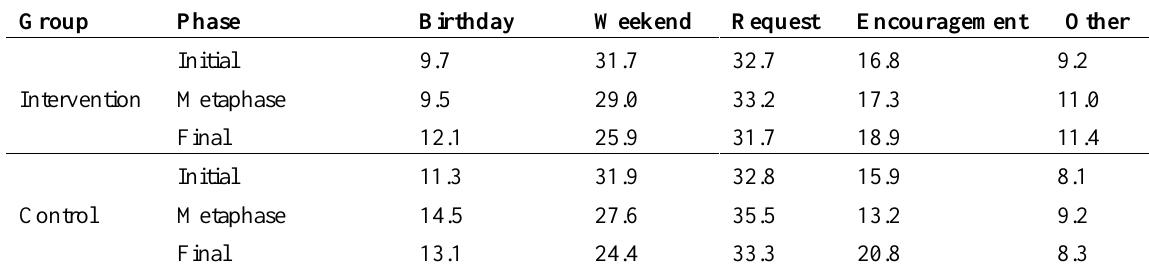
Table 6. The time for consuming western-style foods (%)